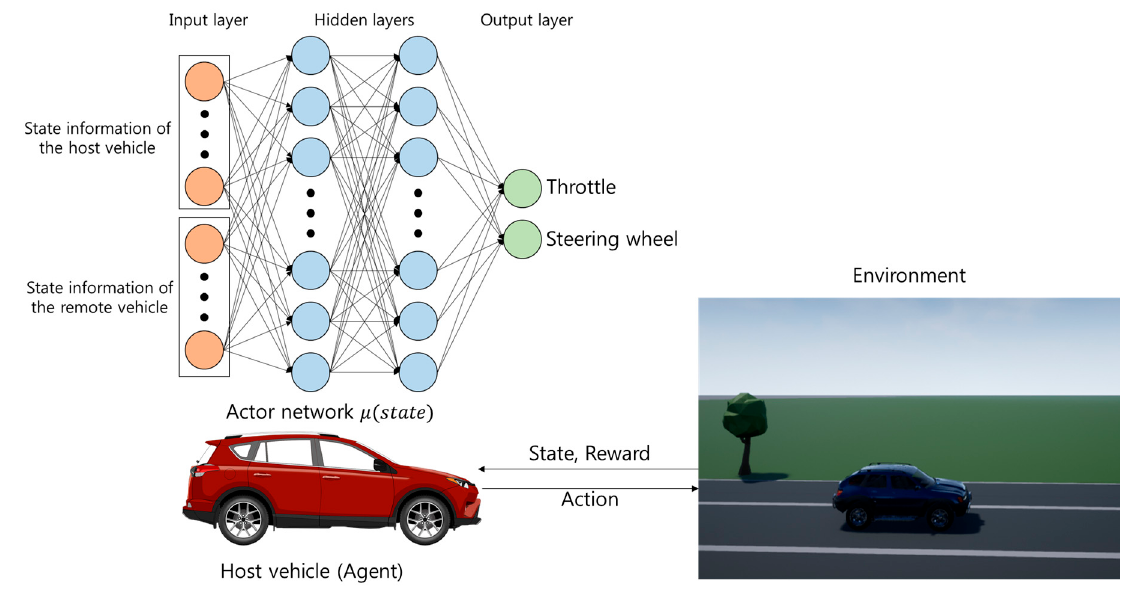
Figure 1. Architecture of proposed decision-making system.